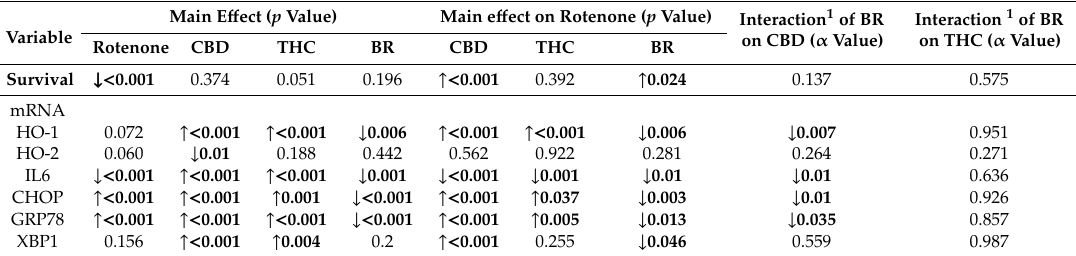
Table 2. Main effects of single compounds and interaction of cannabidiol (CBD), tetrahydrocannabinol (THC), or bilirubin (BR) with rotenone-induced toxicity and the cooperation of BR with CBD on rotenone-mediated effects after incubation for 24 h (for gene expression) and 48 h (for dopaminergic neuron survival) on the respective dependent variables.